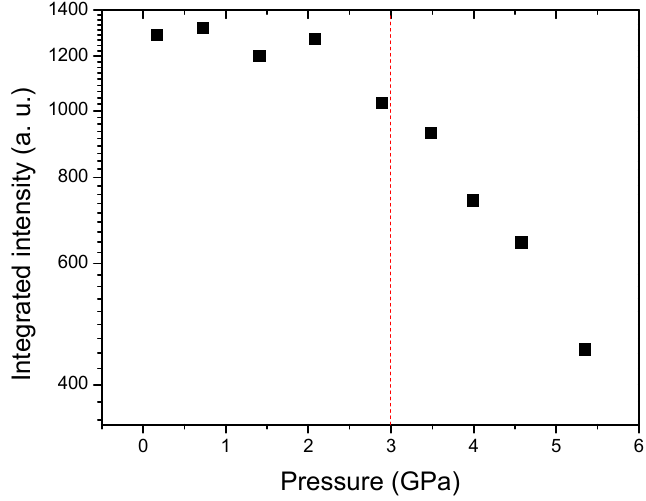
Figure 11. Integrated intensity pressure dependence of the [(CuI) 2 (Quin)] compound.